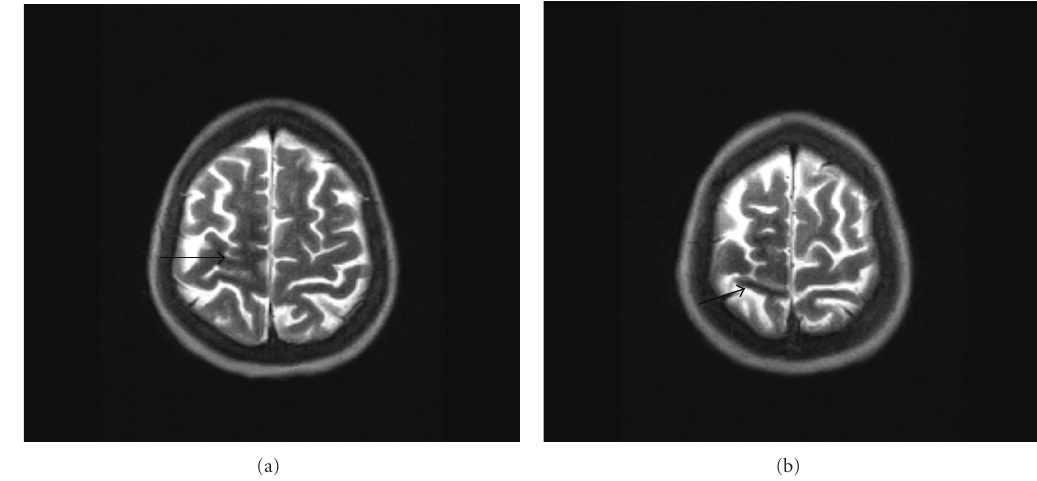
Figure 1: Axial T2 image shows subcortical T2 hypointensity in right pre- and postcentral white matter.